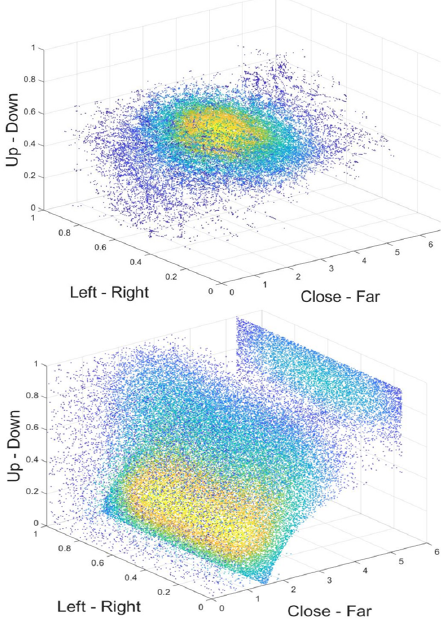
Figure 13: 3D Heat map of one subject. Points are colored ac- cording to the number of close neighbors of a point and thereby code the density of points in this area (yellow=high density,